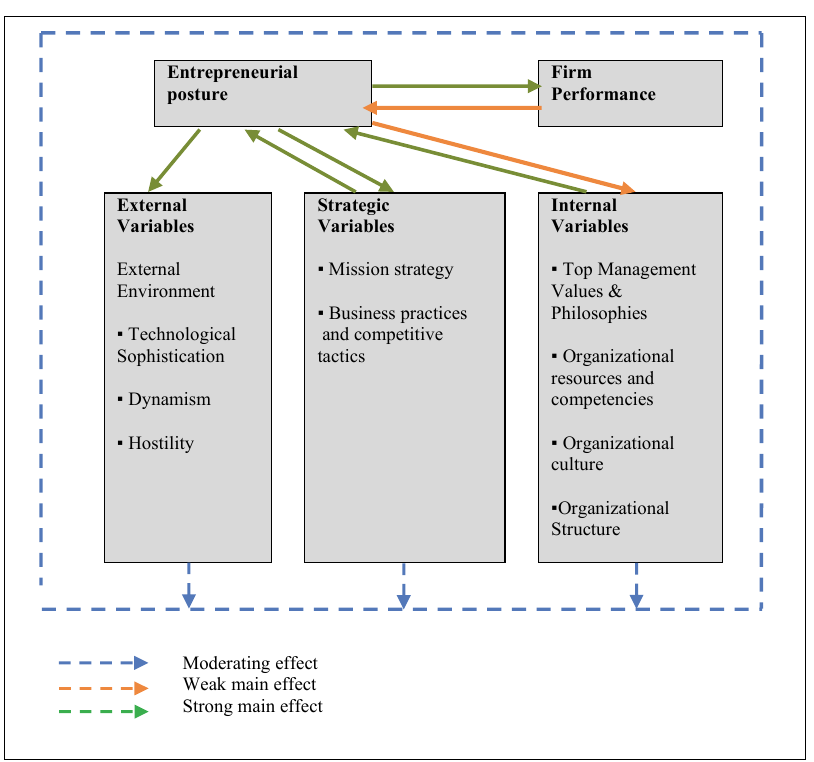
Fig. 1. A Conceptual Model of Entrepreneurship as Firm Behavior Source: Covin and Slevin